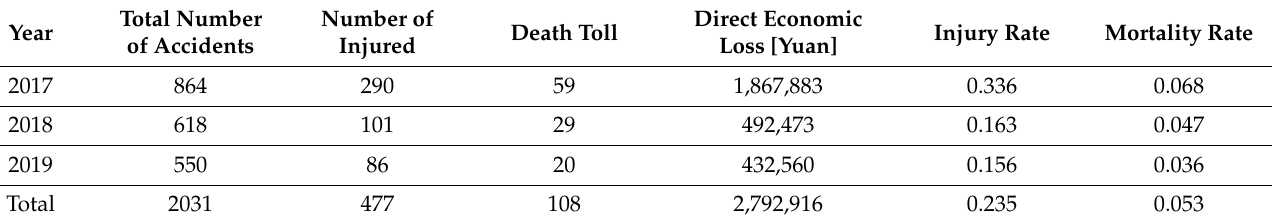
Table 1. Statistical description of traffic accidents of different severity in Shanghai 2017 – 2019.